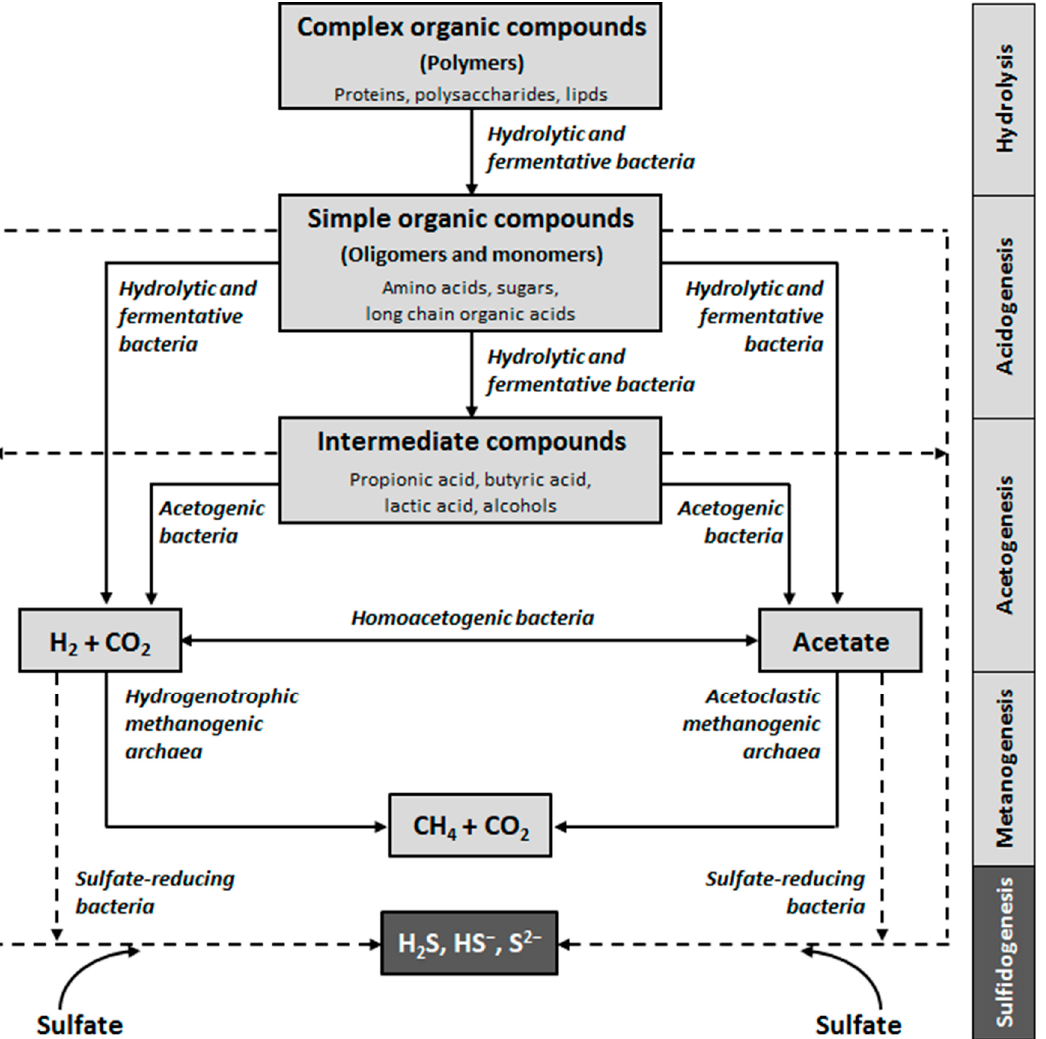
Figure 2. Simplified diagram of the anaerobic bioconversion of organic matter into methane, including the main involved microbial populations. Bold lines indicate the process without the interference of sulfate reduction; dashed lines indicate possible biochemical pathways associated with the reduction of sulfate into sulfide. Note: The diagram is based on McCarty and Smith [150] and Chenicharo [160].